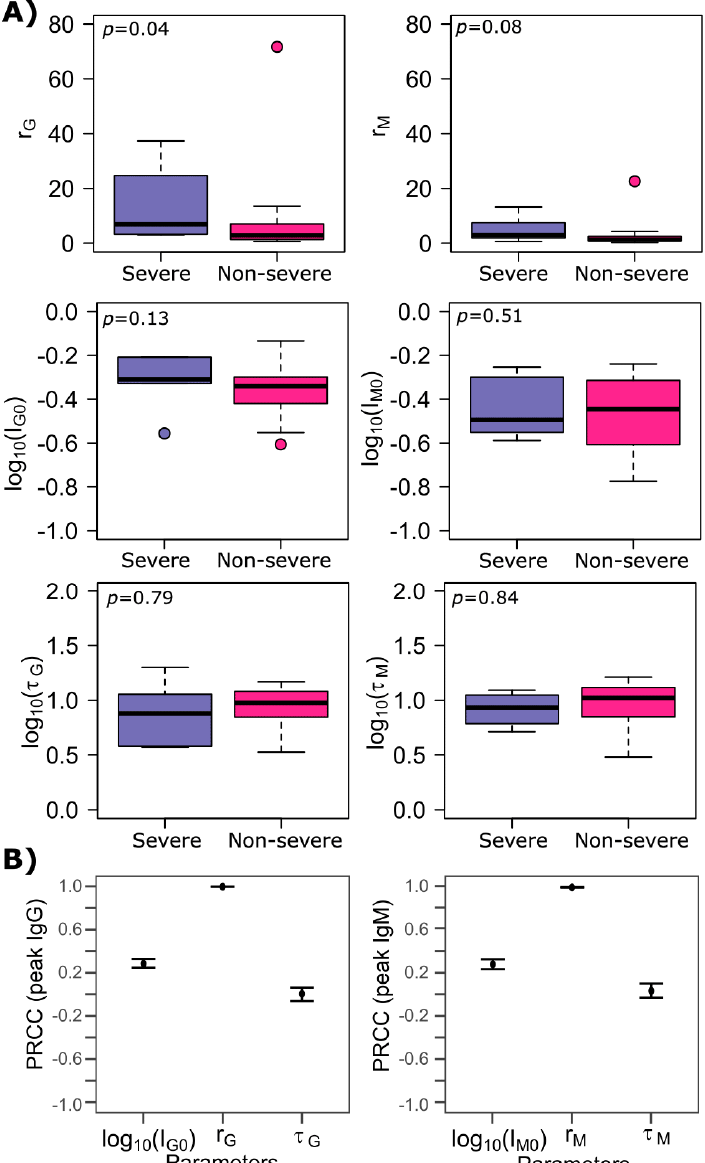
Figure 2. Model parameter comparison between non-severe and severe SARS-CoV-2 cases. ( A ) Comparison of estimated parameters between severe and non-severe patients using Wilcoxon-rank sum test under the model that best recapitulated the longitudinal IgM and IgG data of 6 severe and 20 non-severe-patients. We compared parameters 𝑟 (cid:3014) , log (cid:2869)(cid:2868) (𝐼 (cid:3014)(cid:2868) ) , 𝑟 (cid:3008) , log (cid:2869)(cid:2868) (𝐼 (cid:3008)(cid:2868) ) , log (cid:2869)(cid:2868) (𝜏 (cid:3008) ) and log (cid:2869)(cid:2868) (𝜏 (cid:3008) ) that represent the production rate of IgM, the log-converted concentration of IgM at t = 0, the production rate of IgG, the log-converted concentration of IgG at t = 0, time-delay (since the onset of symptoms) before IgG is produced and time-delay (since the onset of symptoms) before IgM is produced, respectively. p < 0.05 represents a statistically significant difference between severe and non-severe patients. ( B ) Using partial rank correlation coefficient, the sensitivity of the peak IgM and IgG levels to the initial antibody concentration, the production rate, and the delay before the production is induced.